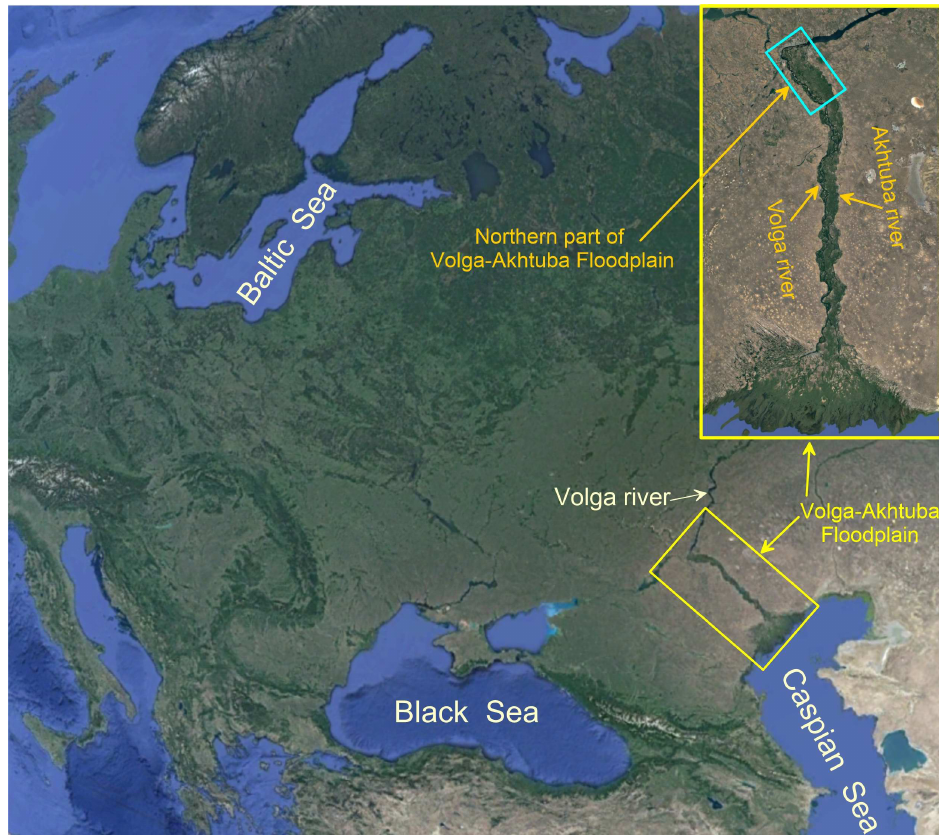
Figure 1. The Volga-Akhtuba floodplain is located in the Lower Volga region from Volgograd City to the Caspian Sea and the length of the interfluve is about 450 km (Google Map